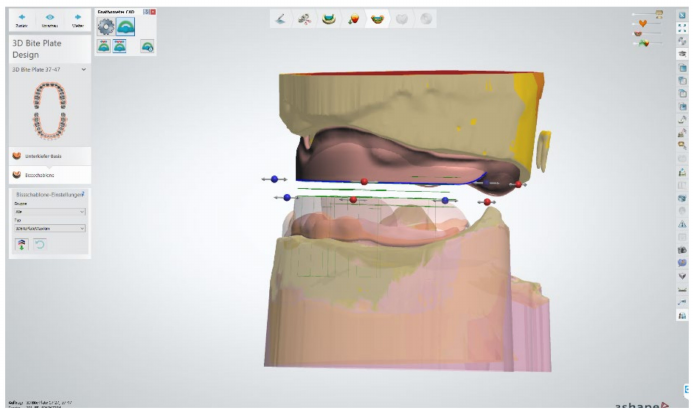
Figure 5. Digitally designed trays on the digitalised cast models.